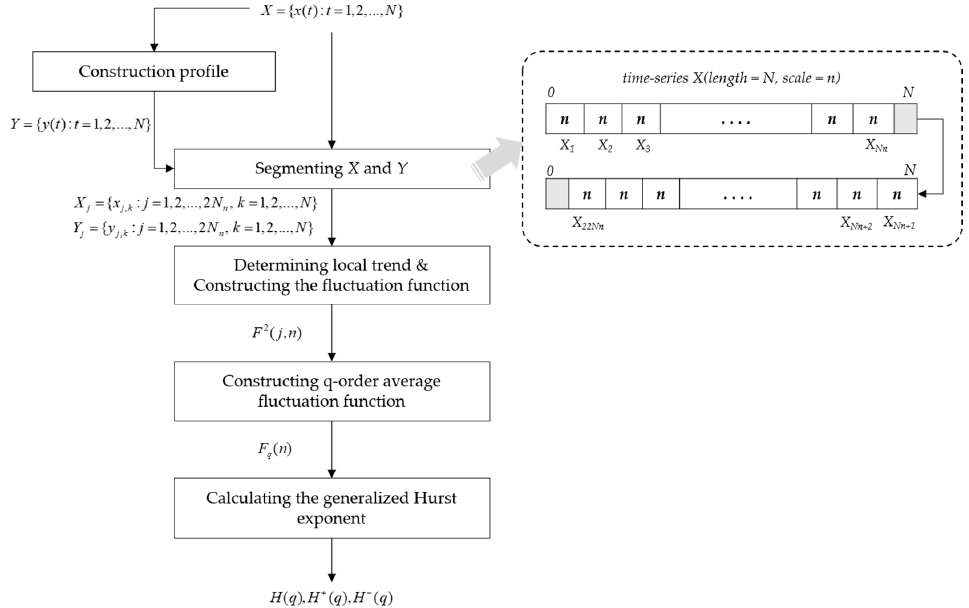
Figure Figure 1. The flowchart of the asymmetric multifractal detrended fluctuation analysis (A-MF-DFA) algorithm.